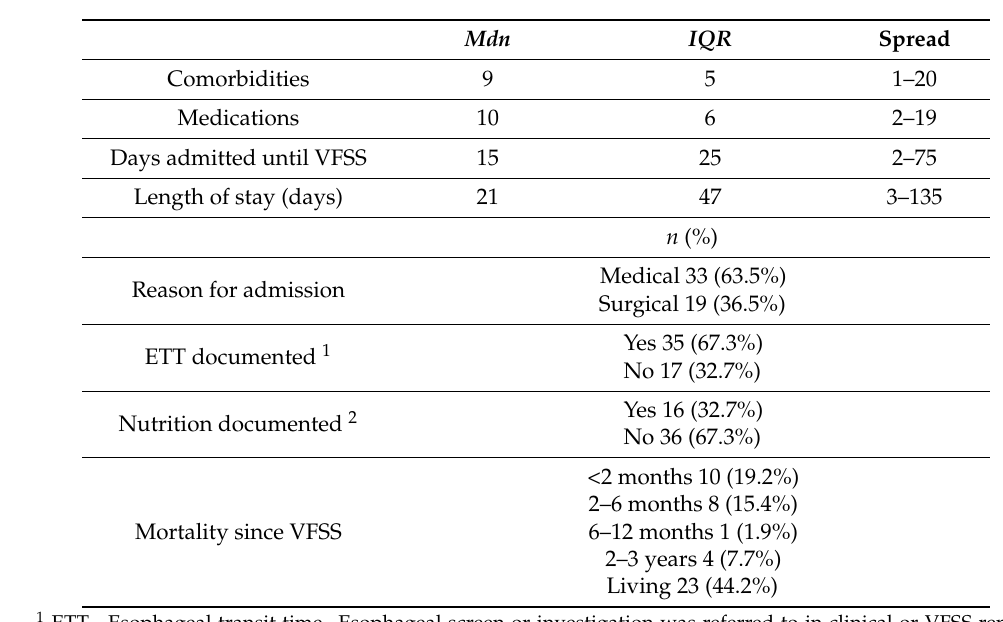
Table 3. Characteristics of hospitalized older